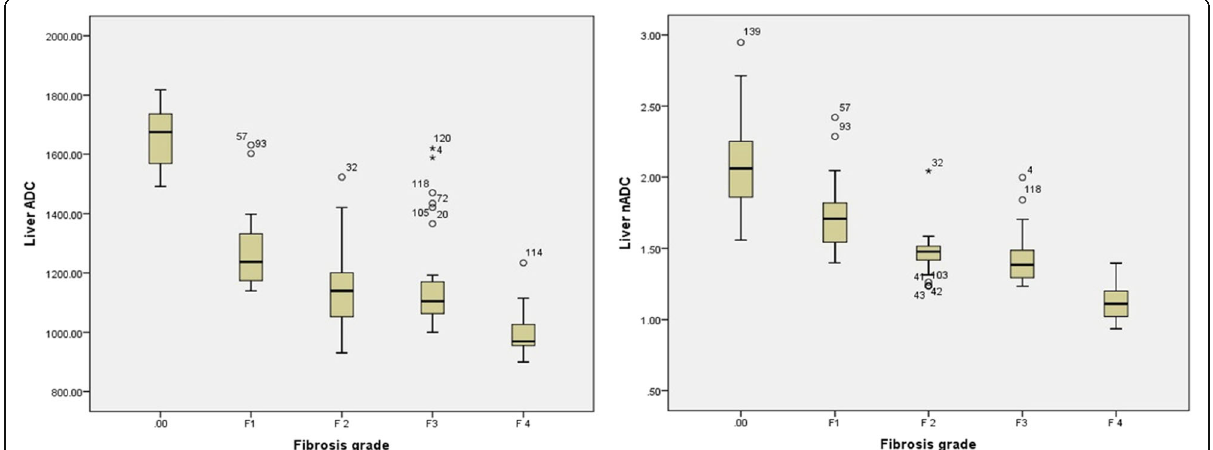
Fig. 5 Box plots showing values of ADC liver and normalized liver ADC for each stage of hepatic fibrosis. There were 112 control cases representing F0 with 21, 40, 36, and 23 patients with fibrosis stages F1, F2, F3, and F4,